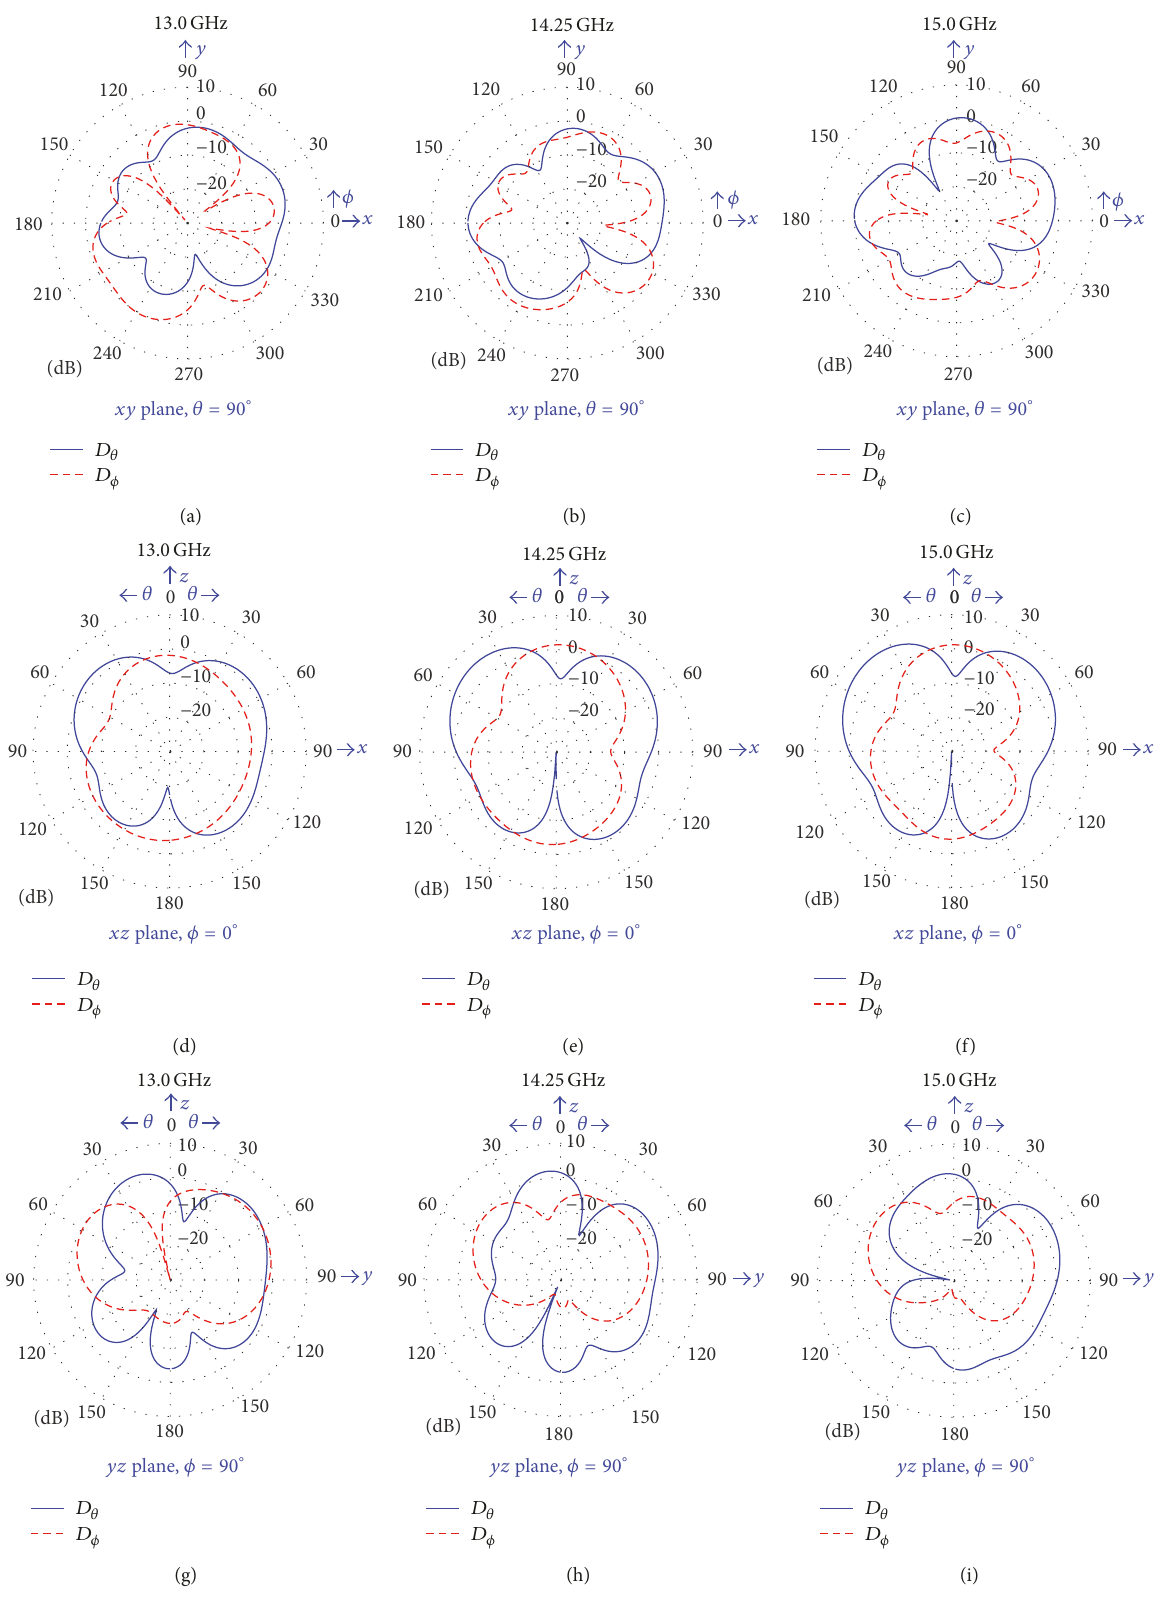
Figure 11: Radiation patterns of the antenna of Figure 10(d) for 13, 14.25, and 15